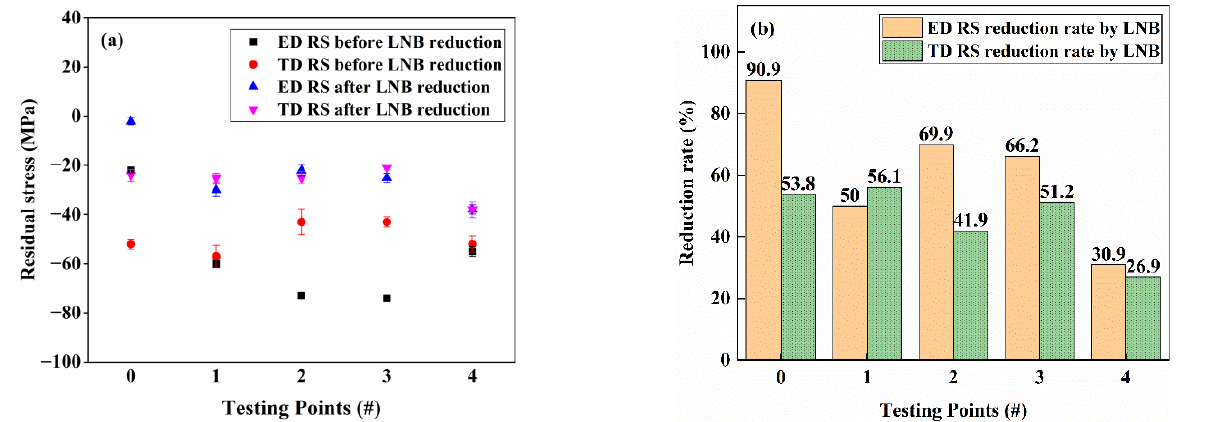
Figure 3. ( a ) ED and TD residual stress and ( b ) relief rate at different points treated by LNB.